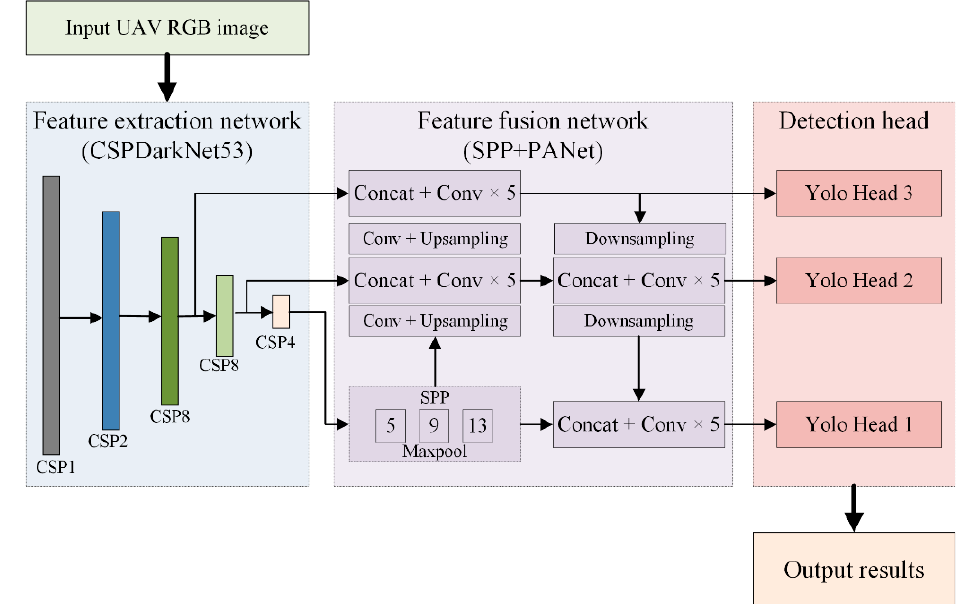
Figure 5. Architecture of YOLOv4 proposed by Bochkovskiy et al. [37].